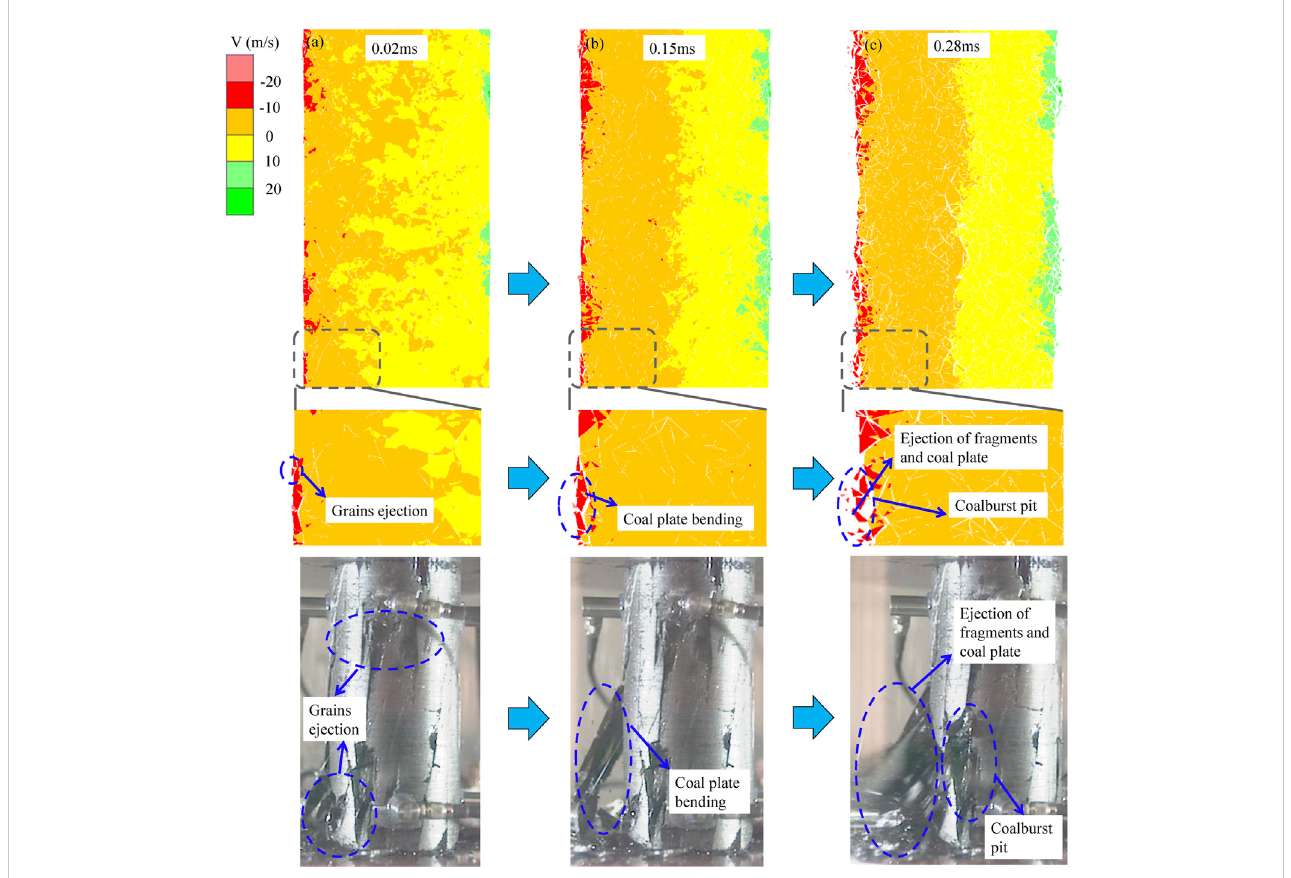
FIGURE 4 Coalburstprocess:numericalandexperimentalresults: (A) grainejectioninlocalzones; (B) coalplatebending; (C) coalfragmentation,plateejectionand V-shaped coalburst pit